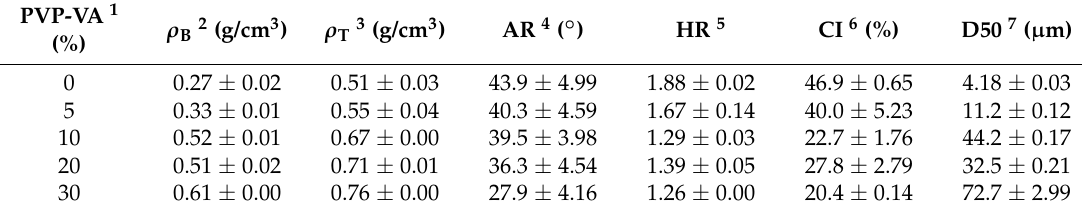
Figure 3. SEM images of the 0 − 30% PVP-VA granules at the same magnification ( × 500). The scale bar indicates 50 µ m. Table 2. Physical properties of SGR granules.